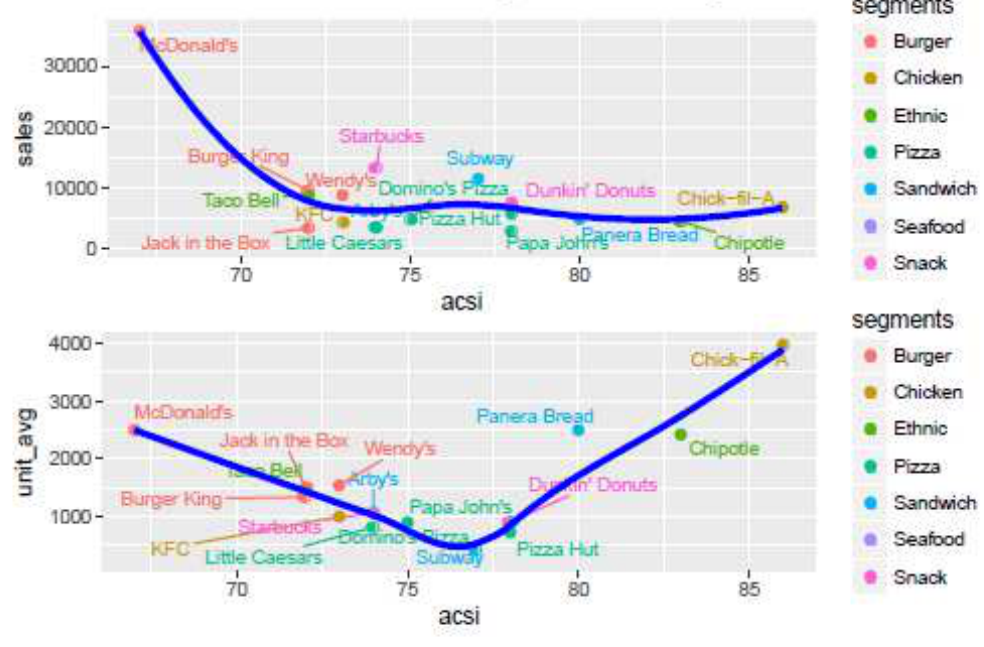
Fig. 4. QSR sales by ACSI and unit average sales by ACSI